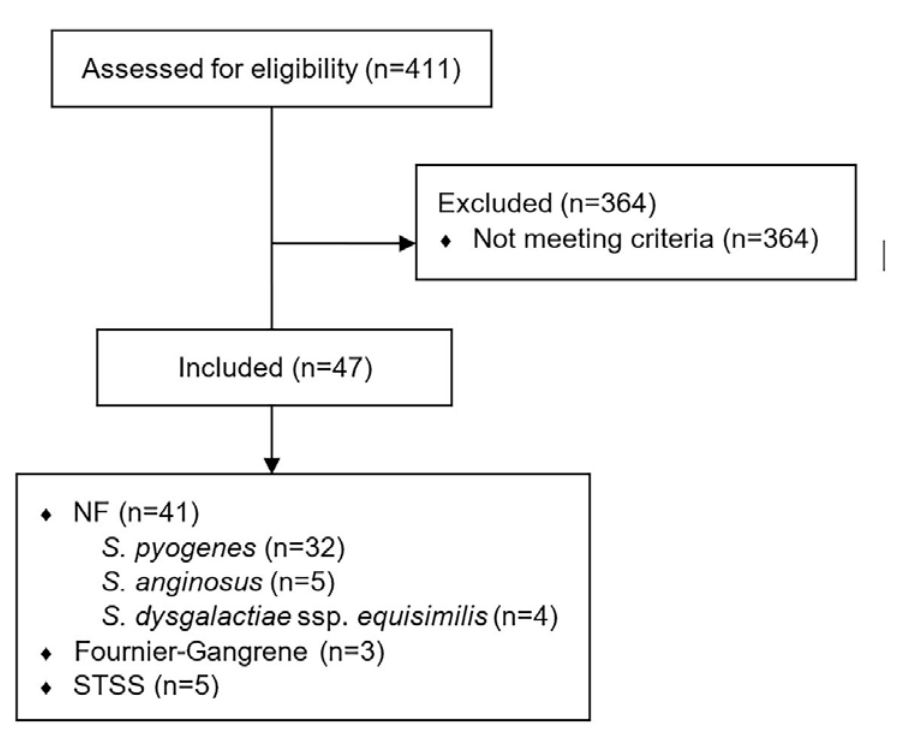
Figure S1: Additional systematic search for the terms “fasciitis”, “STSS” or “Fournier gangrene” in patient records from the internal medicine, plastic surgery, dermatology, emergency and infectious diseases departments between May 2000 and May 2014. Data were available for January 2004 until May 2014. Two patients with NF and STSS were counted in both subcategories. NF = necrotising fasciitis; S. = Streptococcus; STSS = streptococcal toxic shock